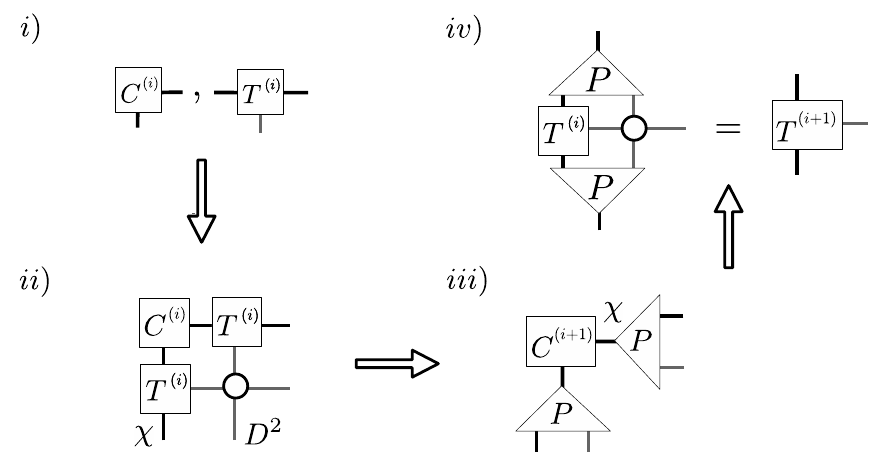
Figure 2: Key steps of the CTM algorithm for single-site iPEPS with C